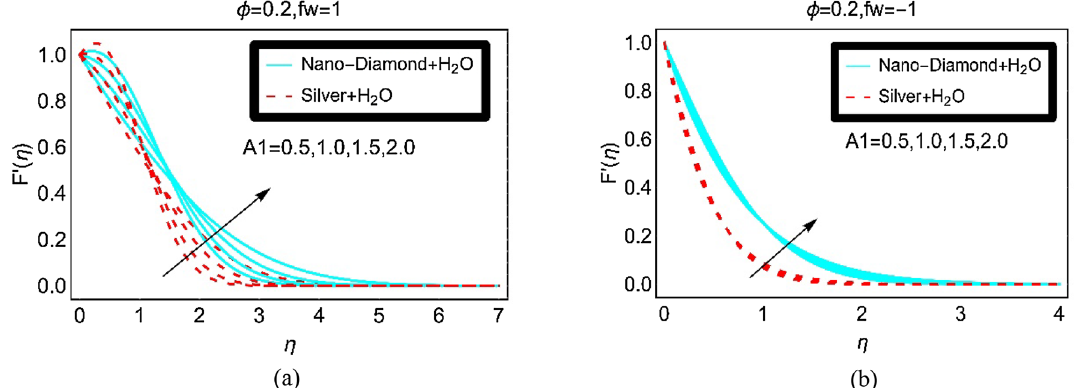
Figure 3. The velocity against ( a ) Suction and ( b ) Injection for varying A 1 .